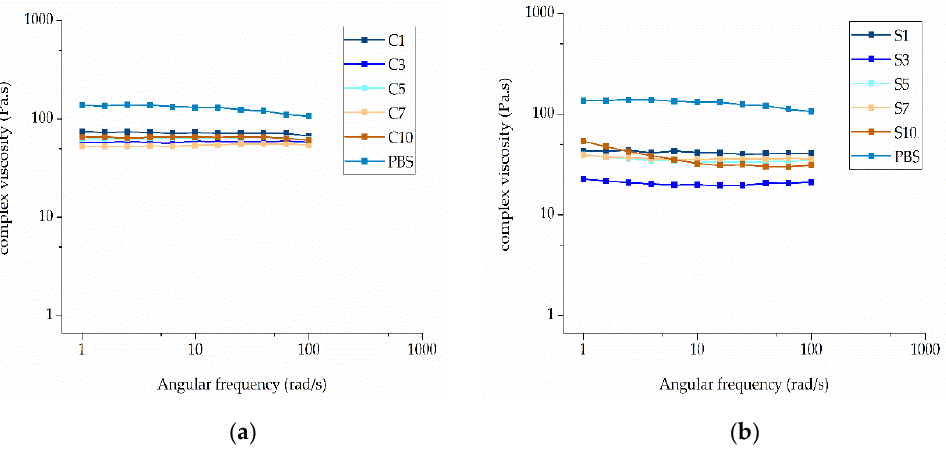
Figure 11. Rheogram showing the complex viscosity of ( a ) PBS-curcumin compounds and ( b ) PBS- silver compounds with increasing angular frequency at 235 °C.